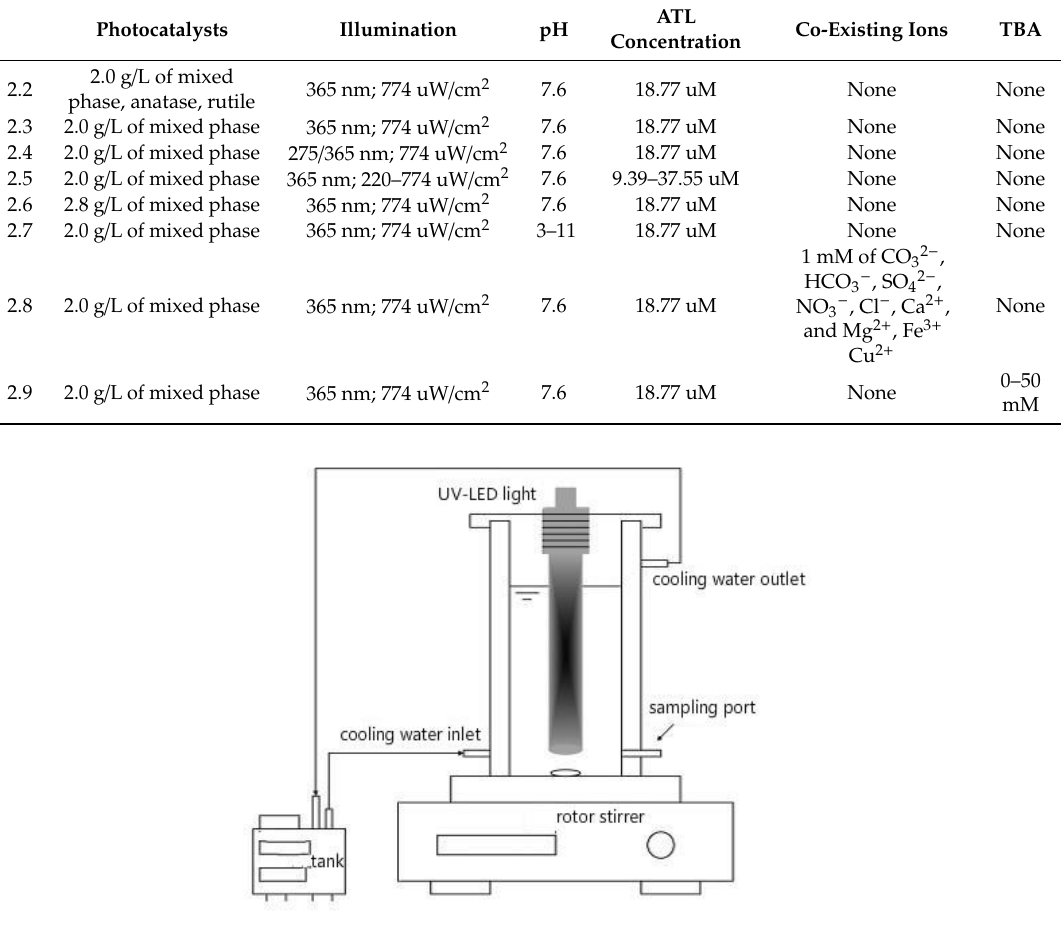
Figure 12. Schematic of the photocatalytic reaction device. Table 4. Different experimental variables regarding atenolol photodegradation with TiO 2 photocatalyst under UV-LED.